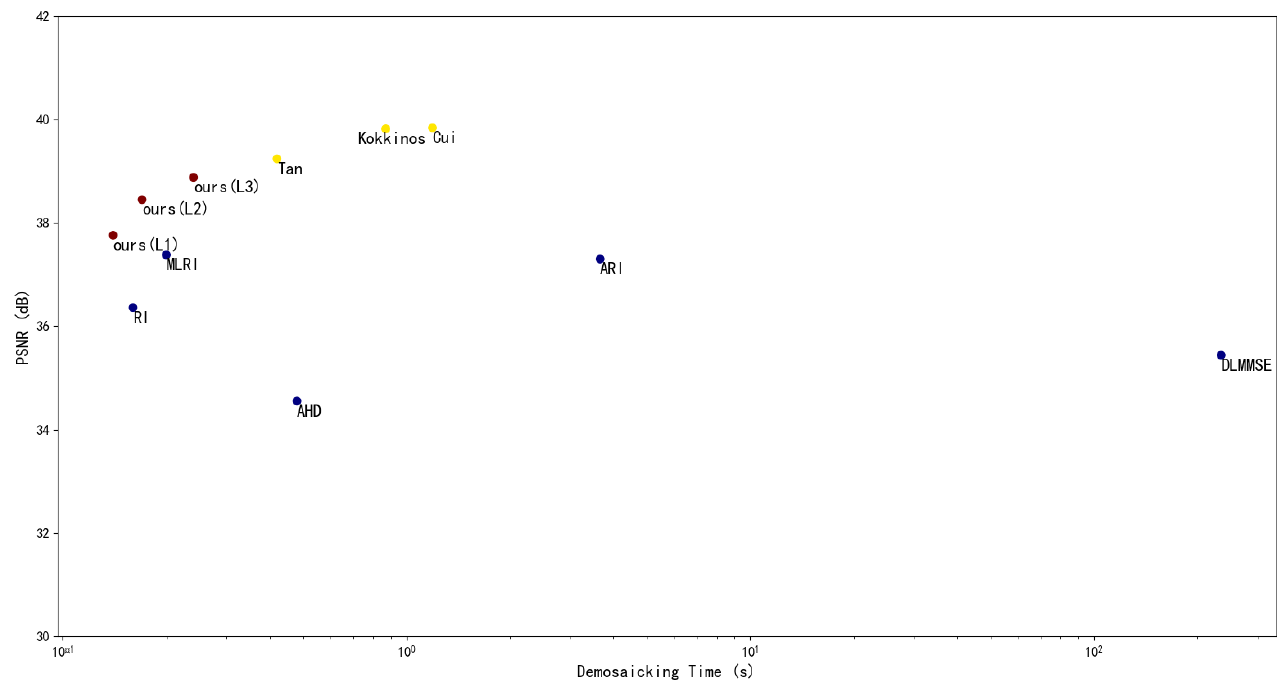
Figure 6. The scatter plot of PSNR s and the running time of log scale on the 9 demosaicking methods.